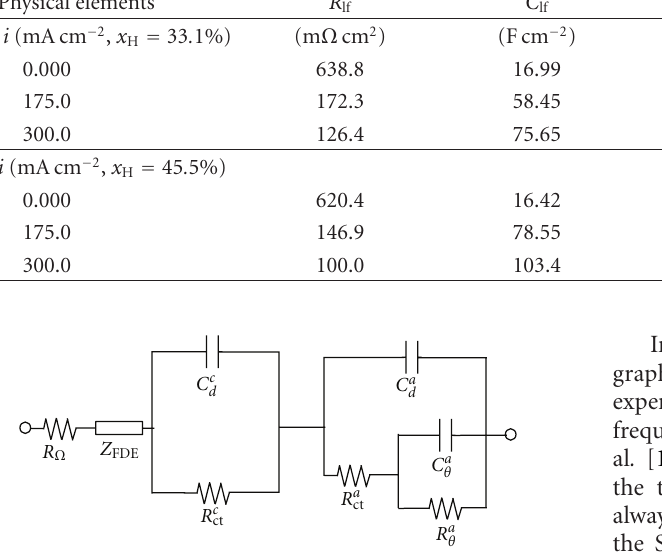
Figure 6: Large cell equivalent circuit model. The circuit has four RC circuits associated with the parallel RCs ( R a and the finite di ff usion element ( Z FDE